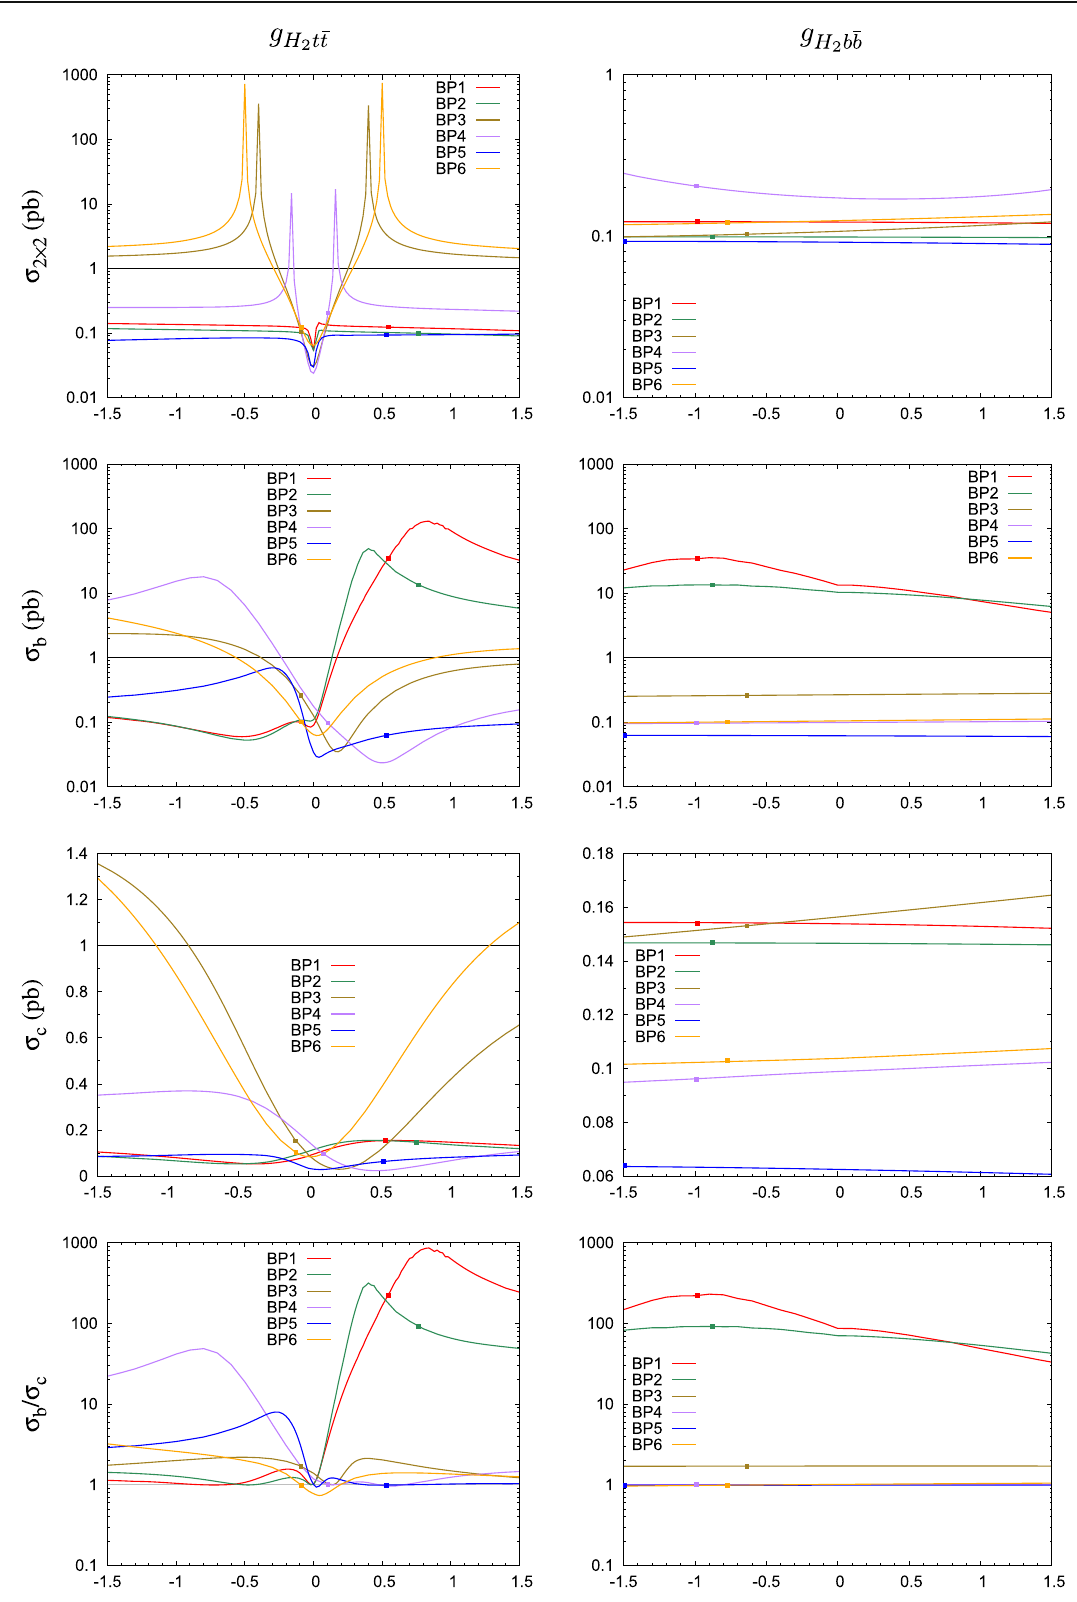
Fig. 6 Various cross sections as functions of the couplings g H coupling for the corresponding BP. See text for more